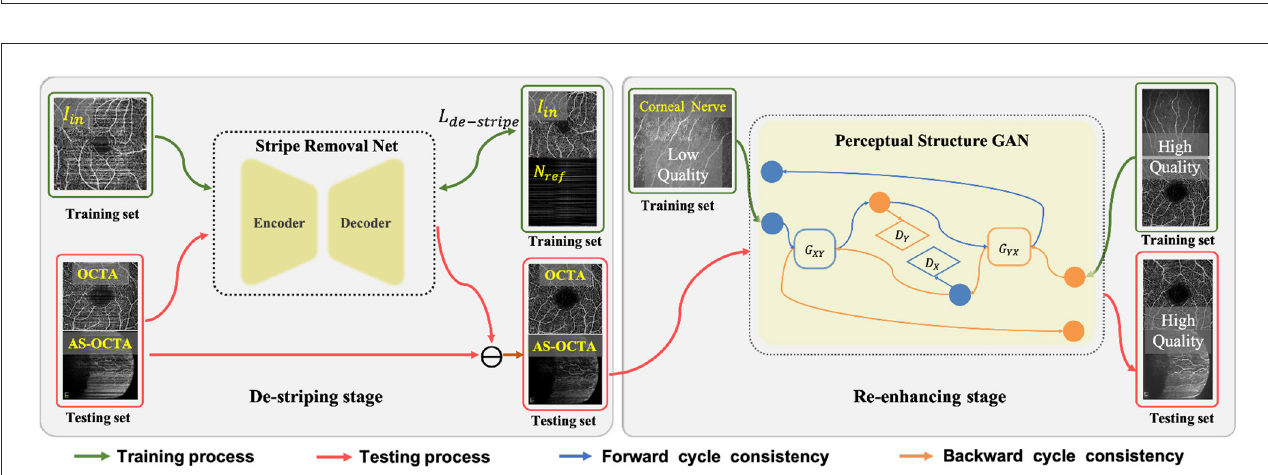
FIGURE2 Overall framework of the proposed two-stage image enhancement method, which includes Stripe Removal Net and Perceptual Structural GAN for de-striping and image enhancement